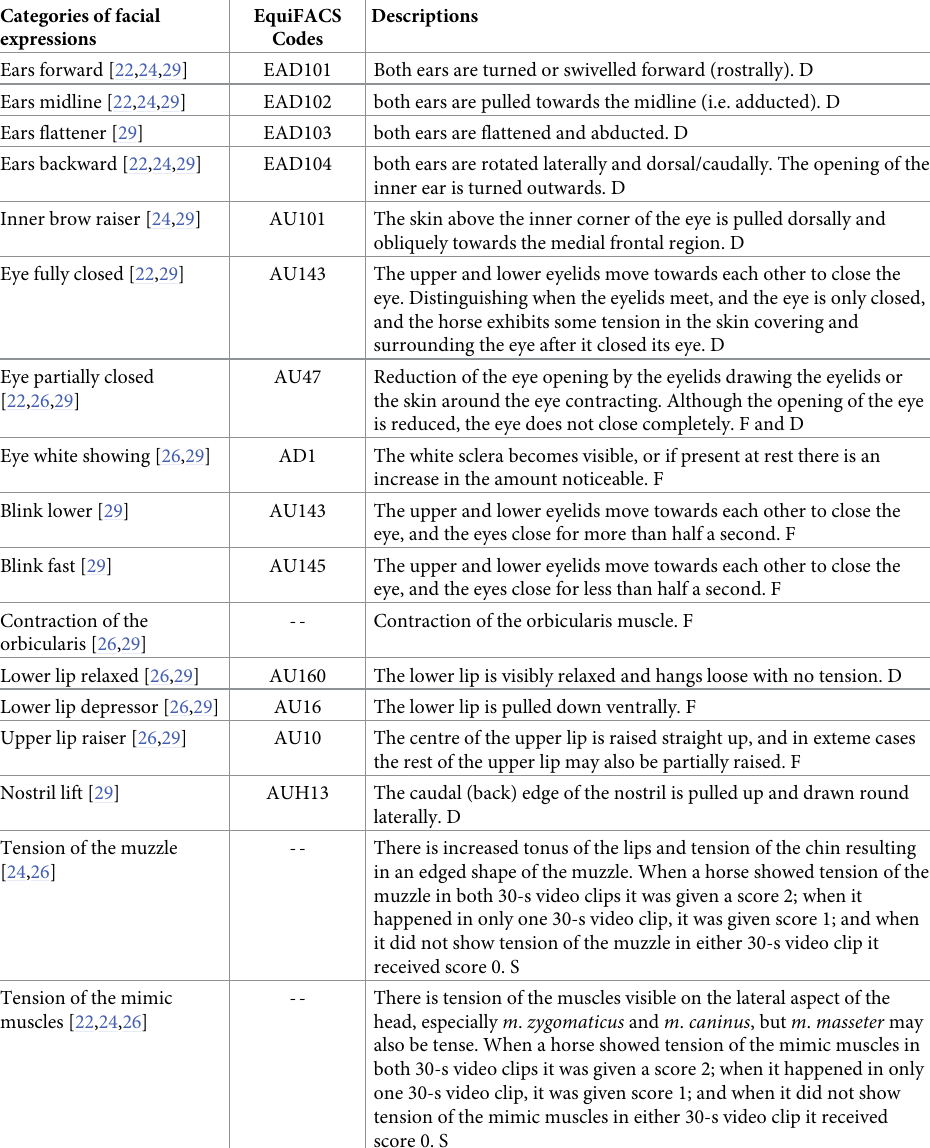
Table 2. Ethogram of the 18 facial expressions variables (adapted from [22, 24, 26, 29]) and their respective recording method (F = frequency, D = duration, S = score; continuous sampling). Categories of facial